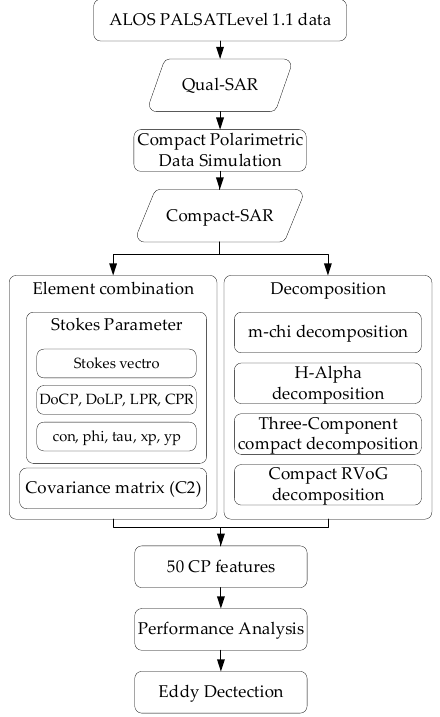
Figure 3. Polarimetric feature extraction flow chart. Table 2. Polarimetric features used in this paper.